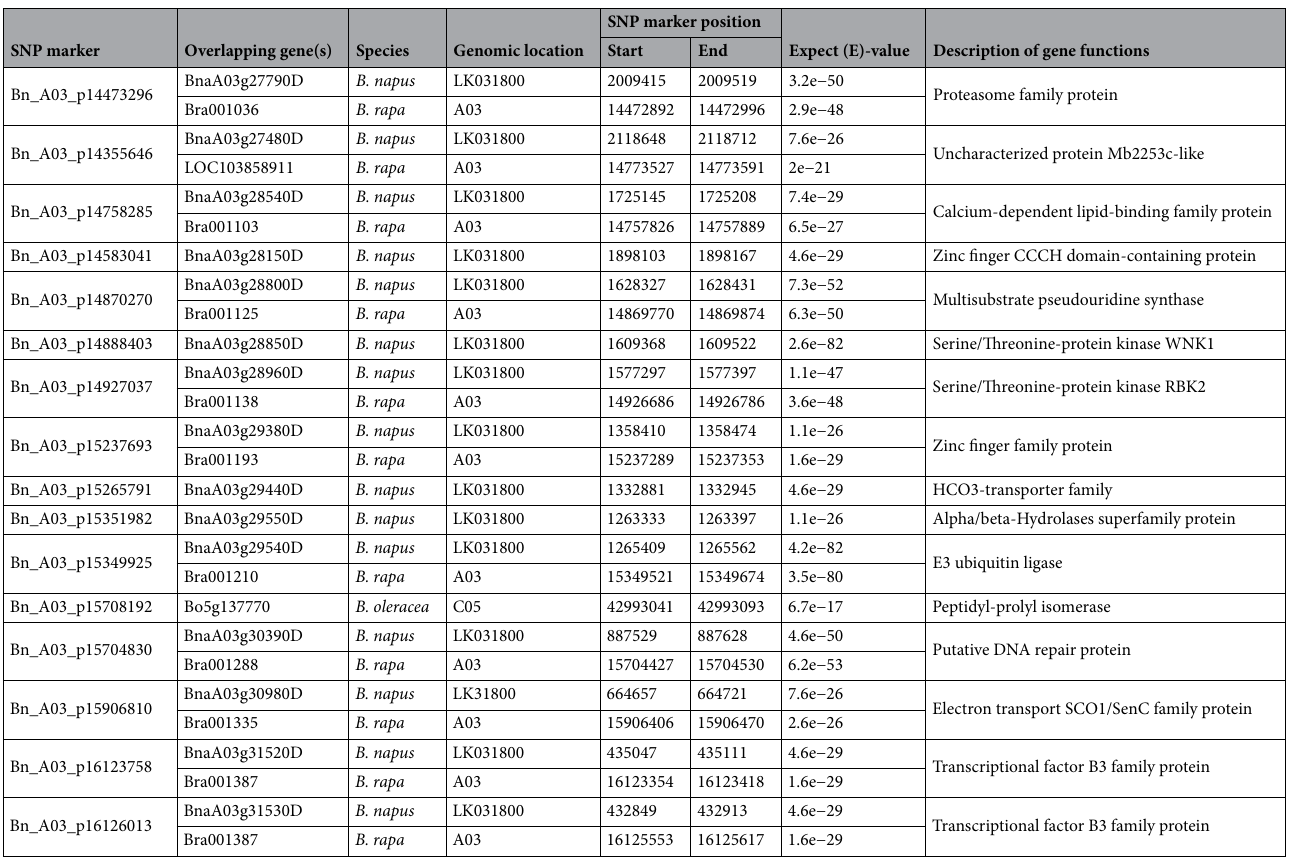
Table 5. Description of the single-nucleotide polymorphism (SNP) markers flanking the major QTL associated with resistance to Plasmodiophora brassicae pathotypes 2F, 3H, 5I, 2B, 3D, 5G, 8E, 3O and 8P.